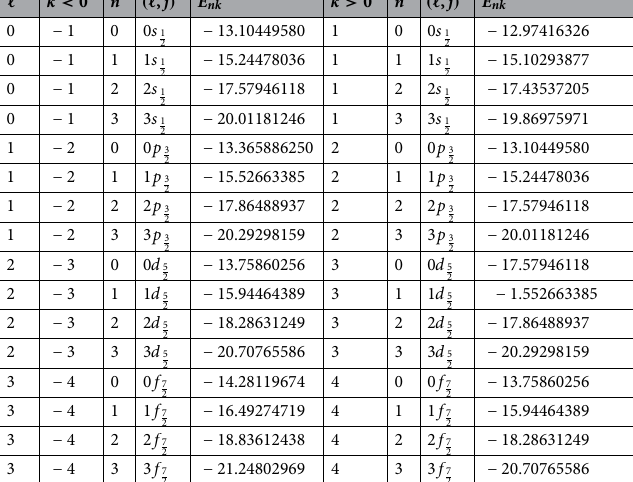
5 fm − 1, v 1 15 fm − 1, b 0.3, M 10 fm − 1, ( (cid:31) = = = =